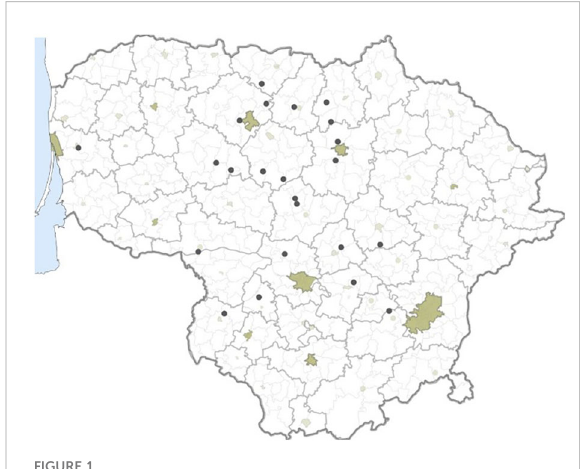
FIGURE 1 Map indicating sampling locations of the Z. tritici population across Lithuania in